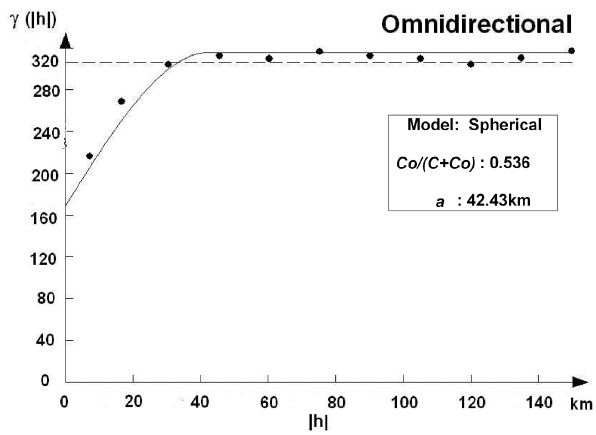
Fig. 6. Empirical semivariogram (dots) and the fitted model (line) of Box–Cox transformed Fig. 6 Empirical semivariogram(dots) and the fitted model (line) of Box-Cox transformed data